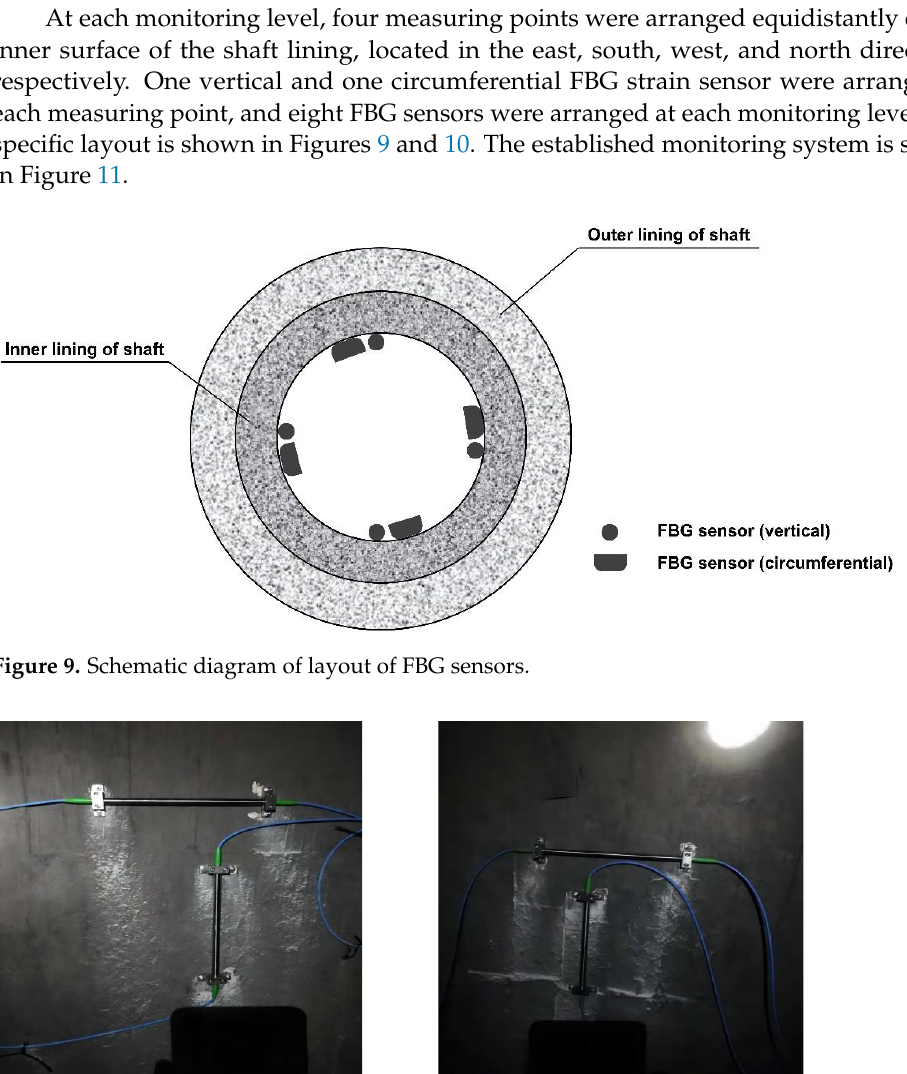
Table 3. Early warning value of vertical strain ( µε ) for shaft lining safety